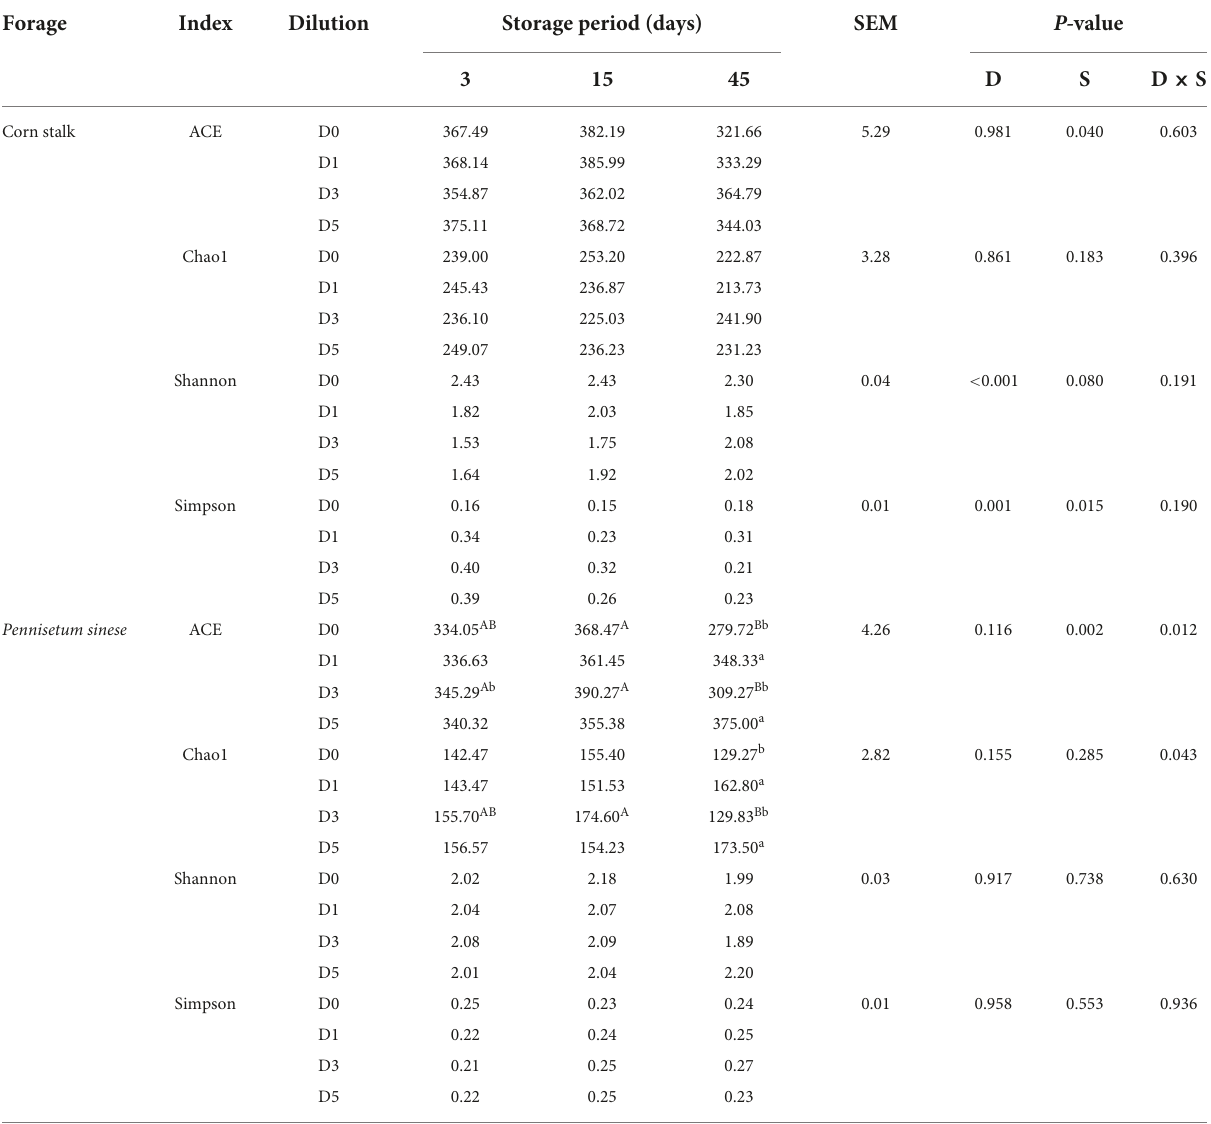
TABLE 3 Alpha diversity indices of corn stalk and Pennisetum sinese silages during ensiling.